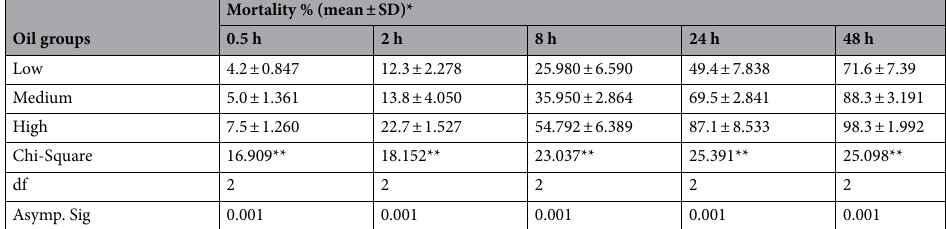
Table 4. Kruskal–Wallis test for larval mosquito mortality (%) of plant oil groups at 1000 ppm. *Means produced by non-parametric analysis (Kruskal–Wallis, p 0.05). **The X 2 value is sig. at significant level 1% H: The highly effective group (95–100% mortalities) are 8 oils ( A. sativum , A. graveolens, C. sinensis, F. vulgare, N. sativa, S. officinalis, T. vulgaris, and V. odorata). M: The moderately effective group (81–92% mortalities) are 7 oils ( B. serrata, C. cyminum, C. aromatic, L. sativum, M. alternifolia, P. nigrum, and S. chinensis). L.: The moderately effective group are included the rest of oils, 17 oils ( A. spinosa, B. carinata, C. libani, C.